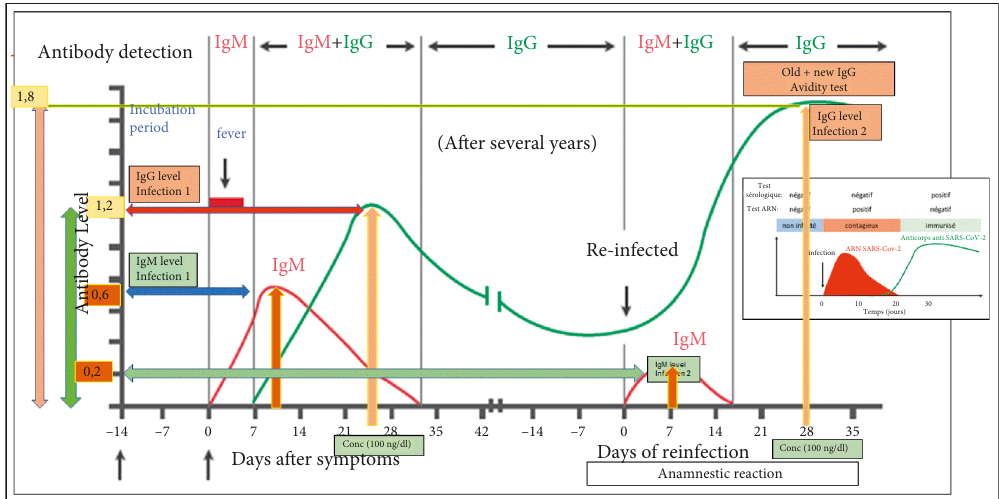
Figure 7: Serological curves of the evolution of IgM Ab/IgG primary invasion versus secondary or anamnestic reaction (Source: Clin- iSciences supplemented by this